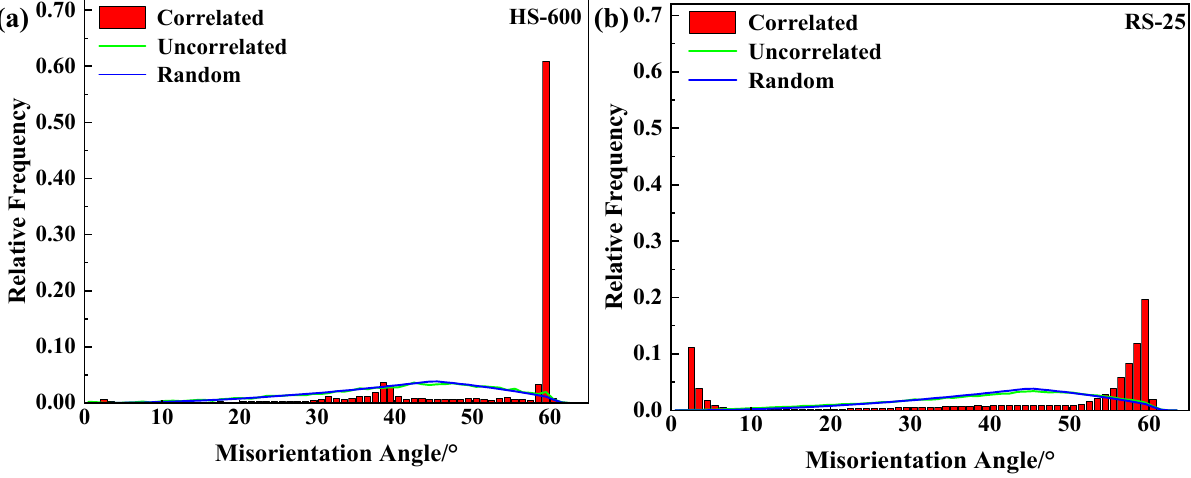
Figure 6. Misorientation angle distributions for ( a ) HS-600 and ( b ) RS-25, respectively. Figure 7a,b shows the grain boundary map (GBs) for RS-25 and HS-600. The HAGBs and LAGBs are represented by black and gray lines, respectively. The CSLs are superim- posed, in which Σ 3, Σ 9, and Σ 27a boundaries are represented by red lines, green lines, and blue lines, respectively. Two main types of twins are generated during deformation, including annealing twins and deformation twins. Annealing twins, mainly related to the recrystallization process, are usually formed by heat treatment, but they can also be ob- tained by directly hot-working [27]. The formation of those twins is a consequence of local strain adjustment and energy minimization required during recrystallization and grain growth. Deformation twins are produced by mechanical deformation. A considerable density of deformation twins will form during cold-working for Ag with a very low twin boundary energy ( ∼ 8 mJ/m 2 [28]).